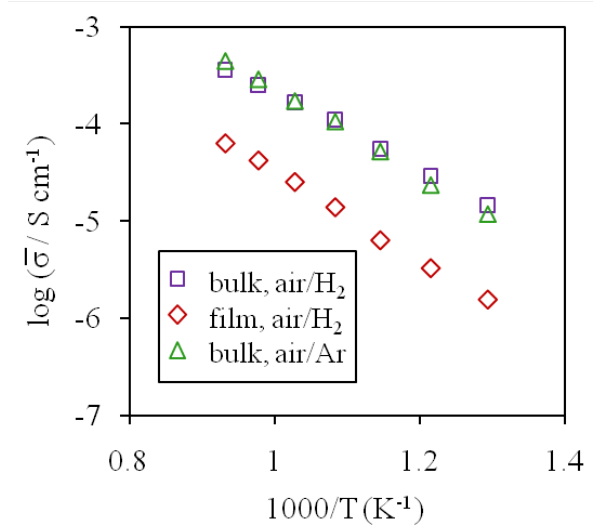
Figure 6. Temperature dependences of the effective conductivity of the bulk and film SZY membranes exposed to p O 2 (air) / p O 2 (H 2 ) and p O 2 (air) / p O 2 (Ar) gradients.